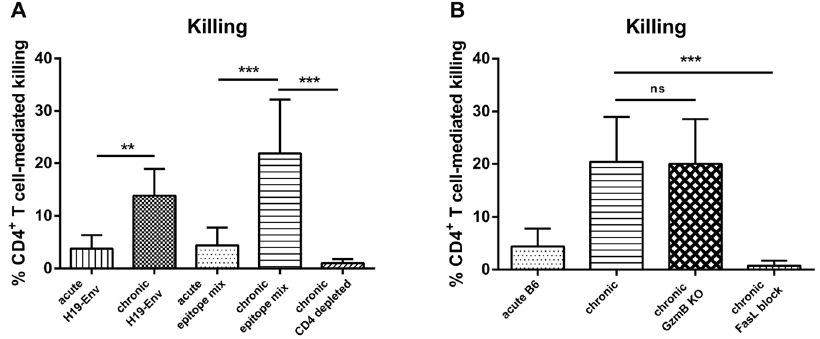
Figure 4. In vivo cytotoxicity of CD4 + T cells during chronic FV infection. Lymph node cells and spleen cells from naïve mice were loaded with CD4 + T cell FV specific epitope peptides and labeled with CFSE dye. Unloaded cells were stained with cell trace violet. Peptide loaded and unloaded cells were injected intravenously in a 1:1 ratio into naïve and FV-infected mice and tracked by flow cytometry 20 hours after injection. The figure shows the percentage of the target cell killing in the lymph nodes. ( A ) Cells from naïve mice were loaded either with H2-A b -restricted F-MulV H19 envelope epitope alone (H19-Env) or with nine additional epitope peptides spanning the coding regions gag, pol, and env (epitope mix), which were described by R.J. Messer et al . 33 and injected intravenously into naïve, acutely FV-infected (n = 8), chronically FV-infected (n = 12), chronically FV-infected CD4 + T cell depleted mice (n = 4). ( B ) Cells from naïve mice were loaded with the peptide epitope mixture. Peptide loaded and unloaded cells were injected intravenously into naïve, acutely FV-infected (n = 8), chronically FV-infected (n = 12), chronically FV-infected GzmB KO mice (n = 8), chronically FV-infected mice, receiving a FasL blocking antibody (n = 4). Mice receiving an isotype control antibody did not show any difference to the non-treated control group. Mean values are indicated by a line. Statistically significant differences between the groups were determined by the unpaired t test: ** p < 0.005; *** p < 0.0001, ns, not significant. Data were pooled from two independent experiments.